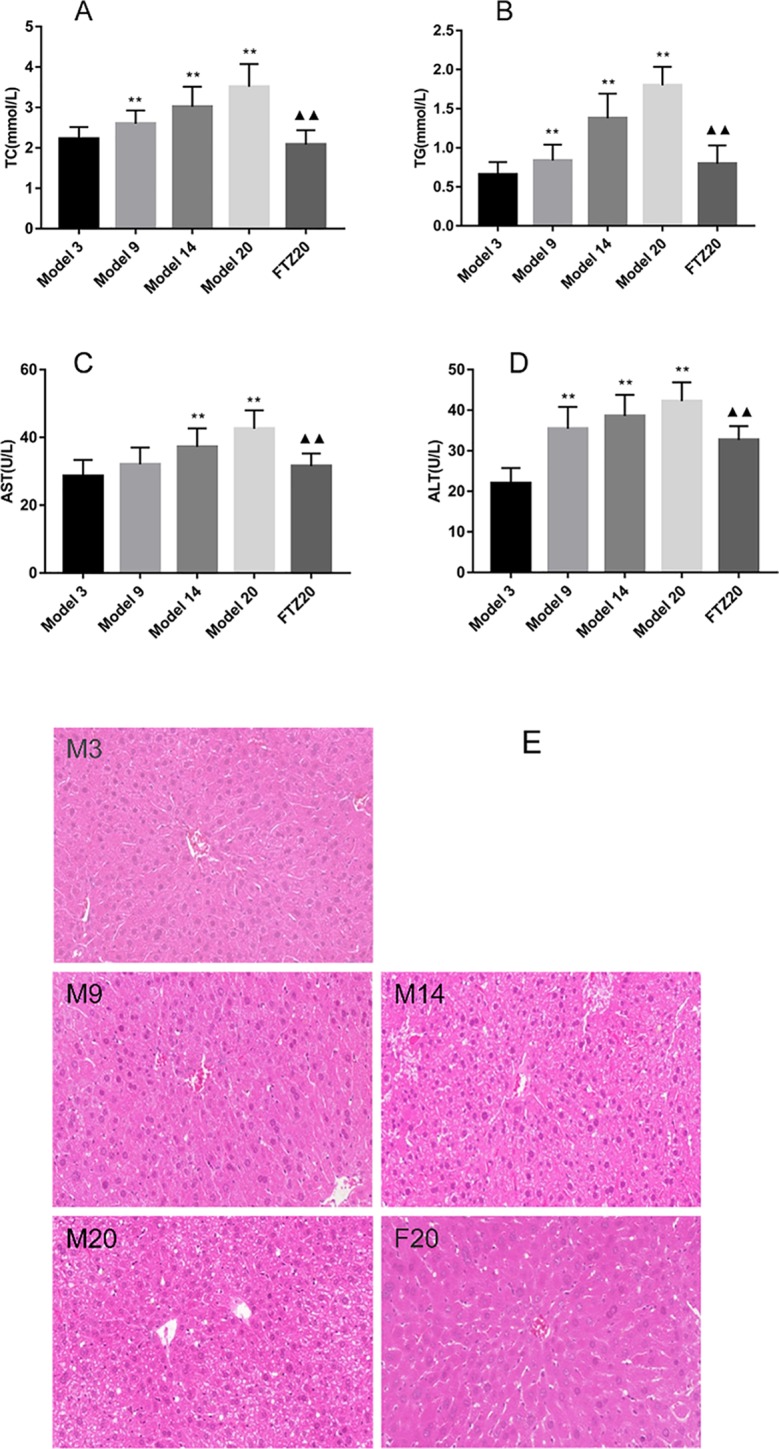
(A–B) TG and TC contents in liver of aging mice. (C–D) Liver function indicators AST and ALT levels. (E) Mouse liver pathology H&E staining (100x). **P < 0.01 compared to model 3 group; ▲▲P < 0.01 compared to model 20 group.